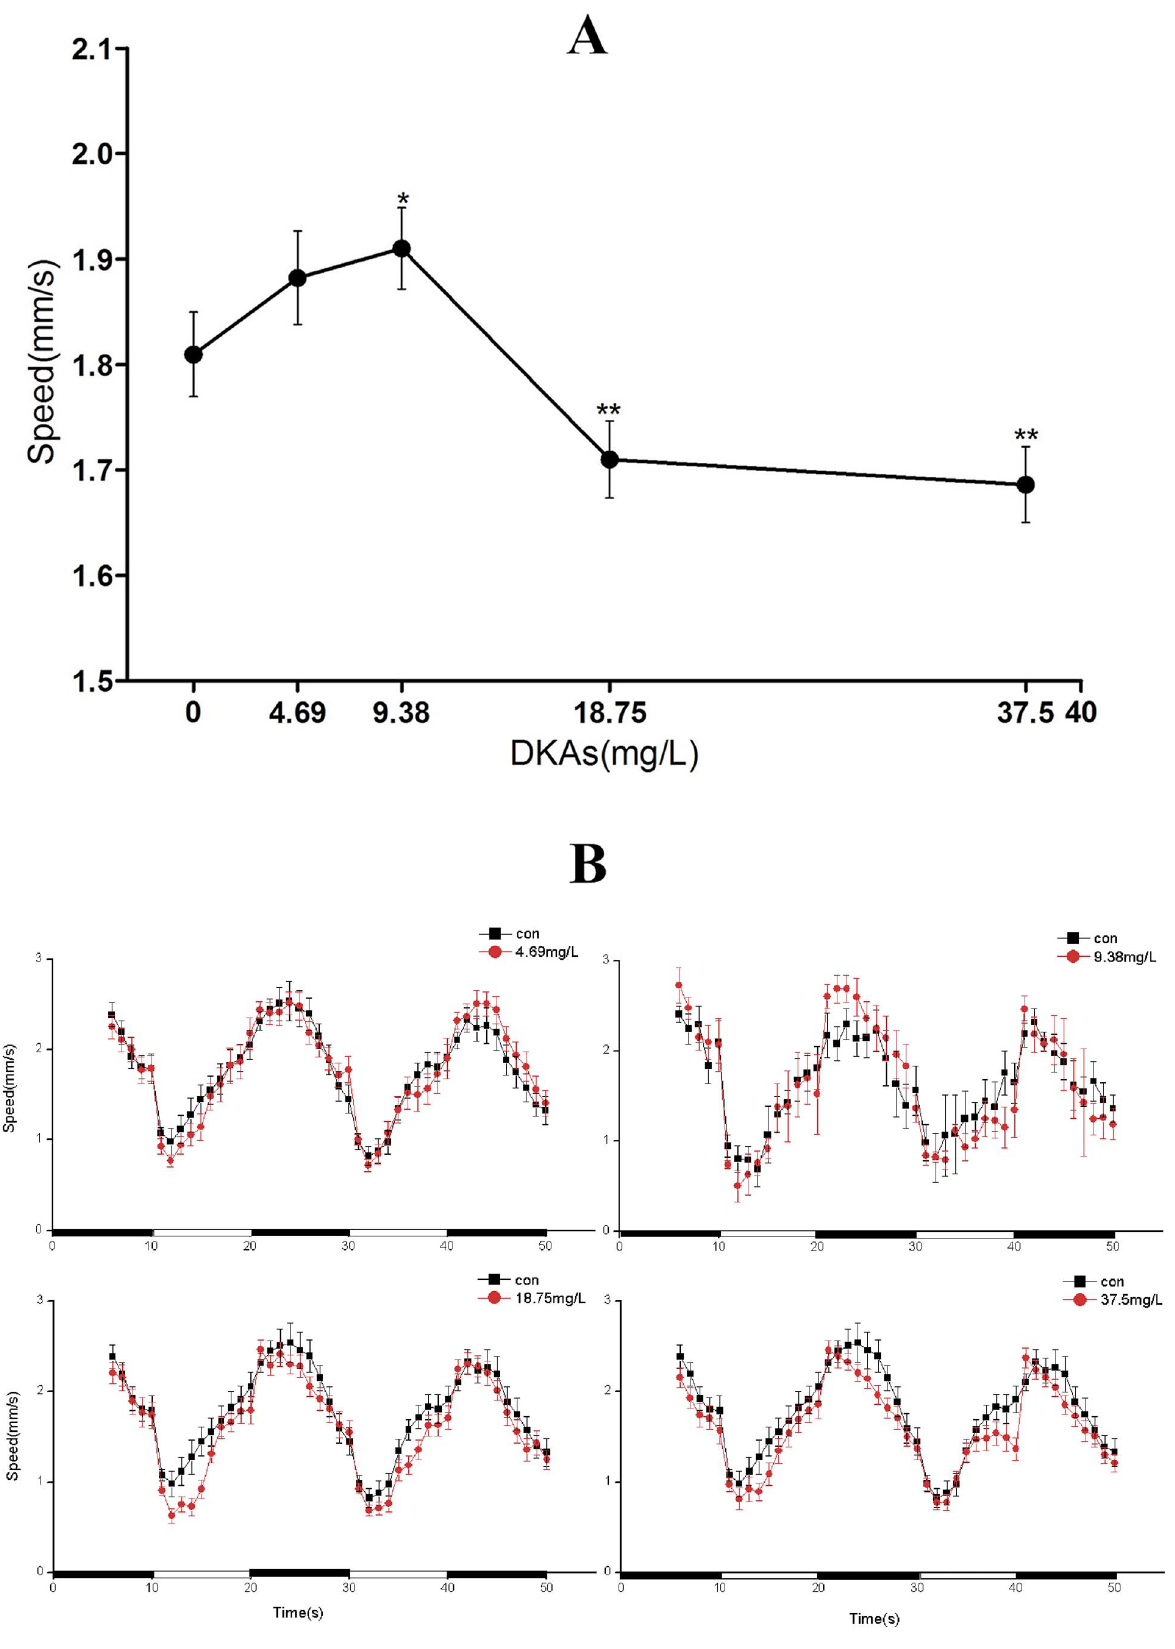
Figure 4. The swimming speed of larvae exposed to various DKA concentrations from 6 to 96 hpf when subjected to a 20 min light period (A) or a 50 min dark-to-light photoperiod (B) at 120 hpf. doi:10.1371/journal.pone.0102731.g004 PLOS ONE |